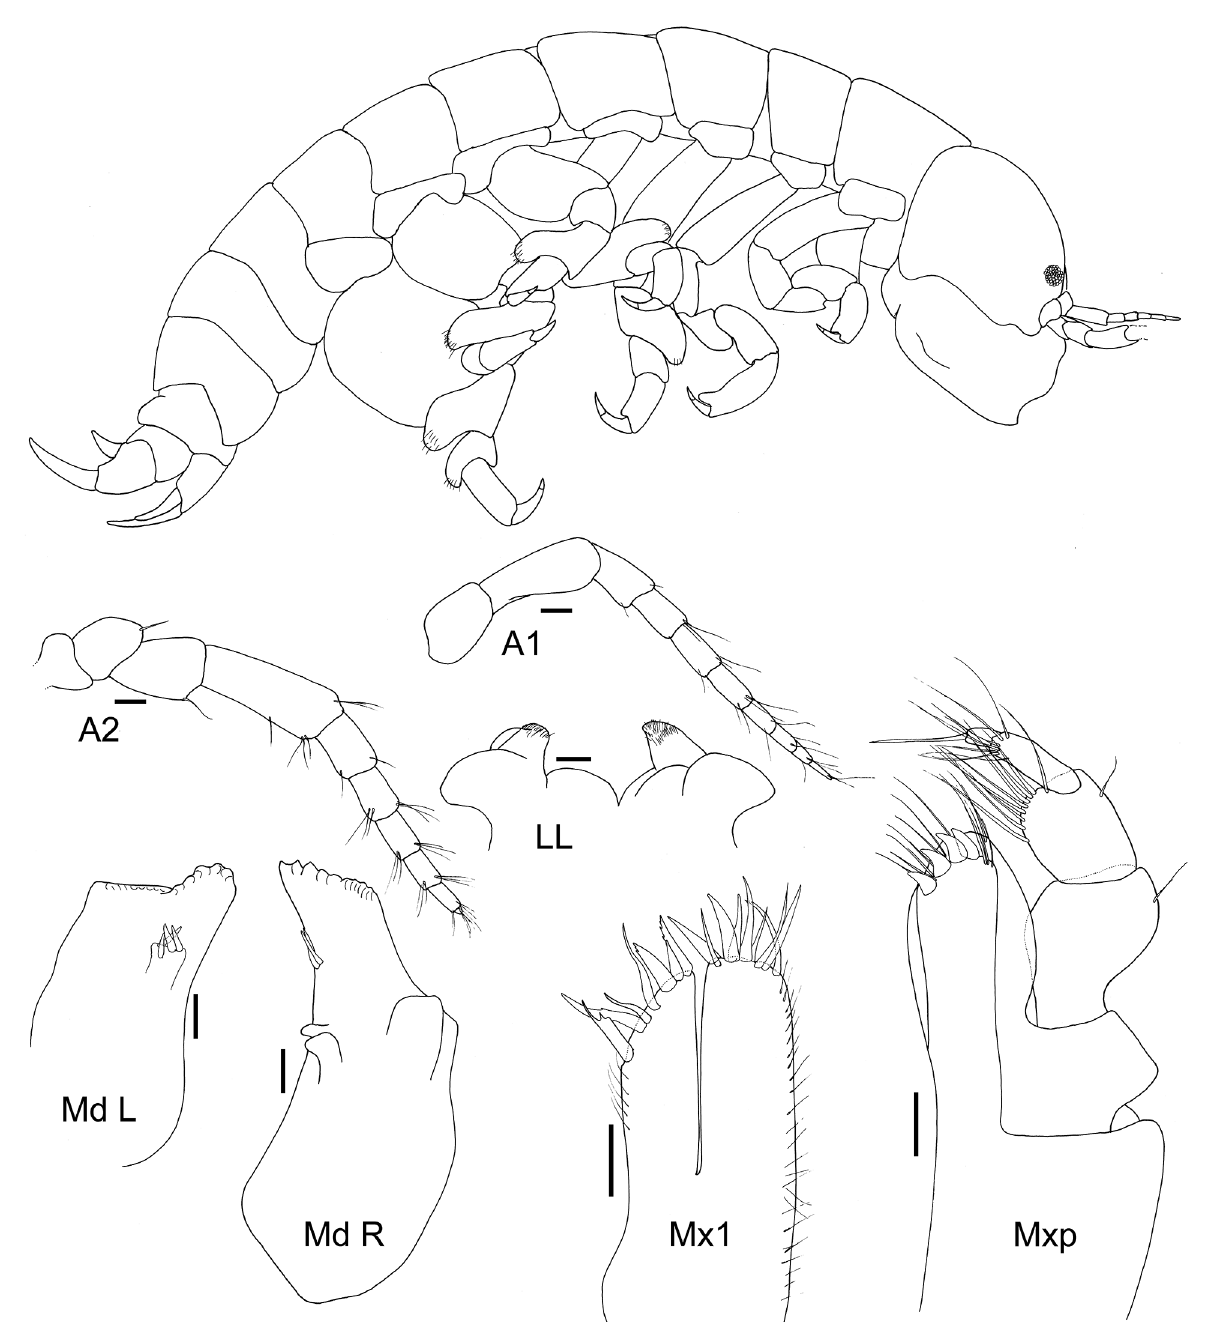
Figure 4. Bircenna thieli sp. nov. holotype female, 6 mm, AM P.100645, Bicheno, Tasmania, Australia. Scale bars: 0.1 mm.